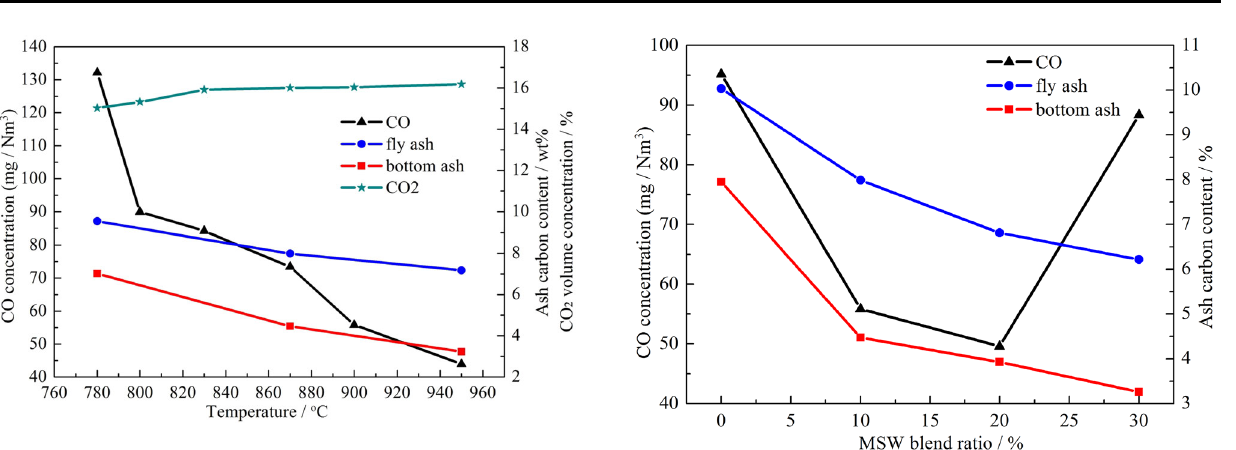
Fig. 2 Effect of bed temperature on the CO/CO 2 emission and carbon content in the ash